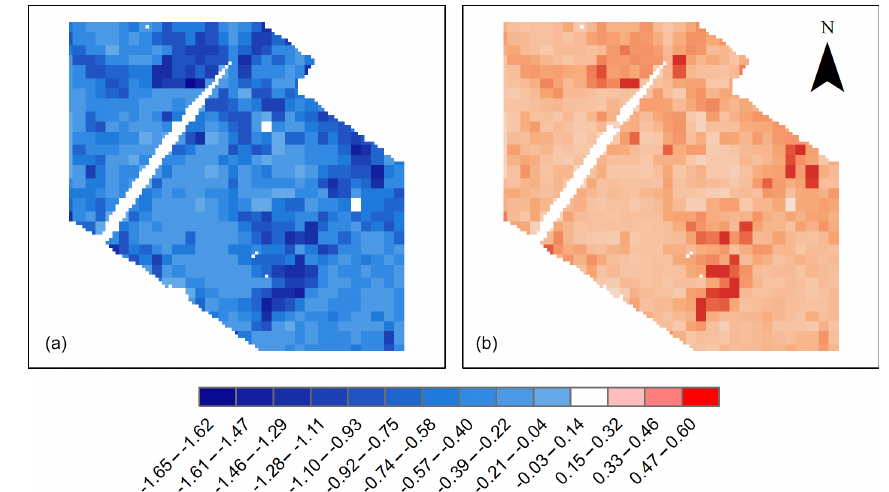
Figure 9. The (cid:49)T ac ( ◦ C) for IRRIGATION − BASE at (a) 15:00 and (b) 03:00 for the Mawson Lakes